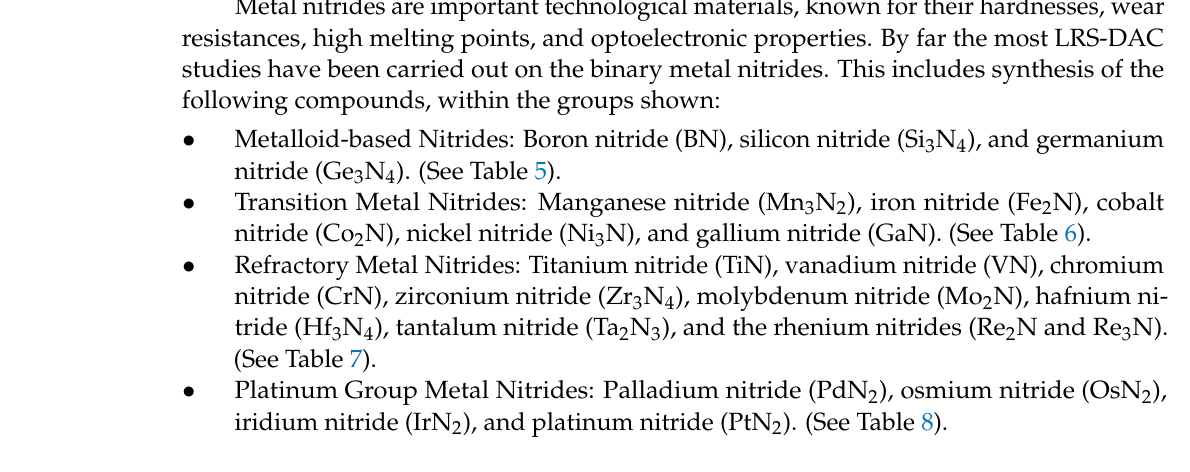
Table 5. Binary Metalloid-Based Nitrides: Metalloid Nitrides Synthesised During Selected LRS- DAC